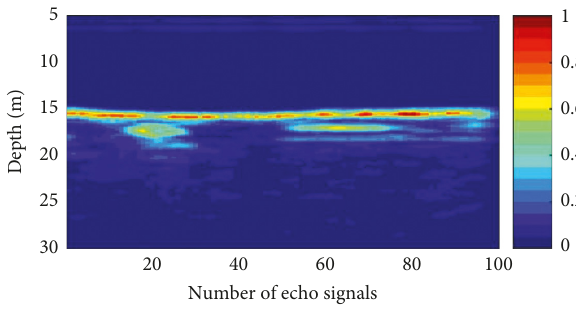
Figure 9: Pipeline